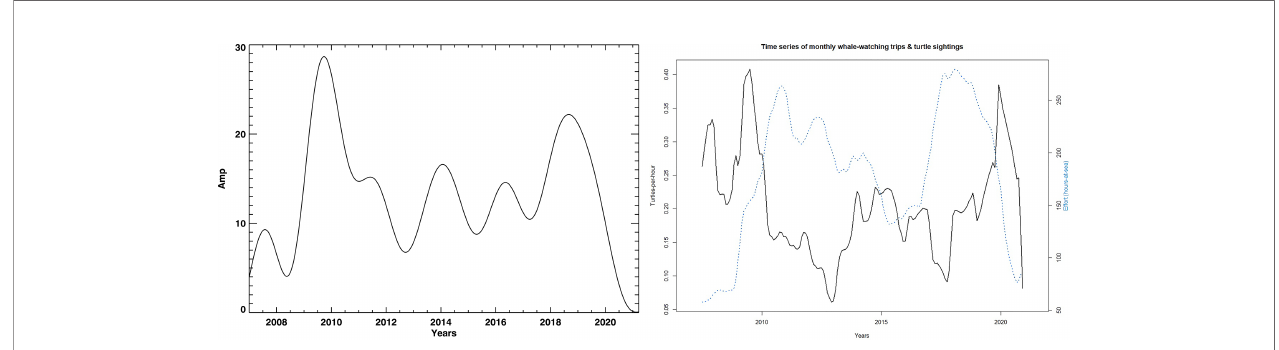
FIGURE 3 | The left plot shows STL decomposition trend lines and boating search effort measured as hour-at-sea (blue) and turtle sightings (black). The right plot shows the trend extracted by using the spectral analysis. It shows a long-period variation in the number of turtle sightings. All trends are shown for the whole interval: 01.01.2007. —